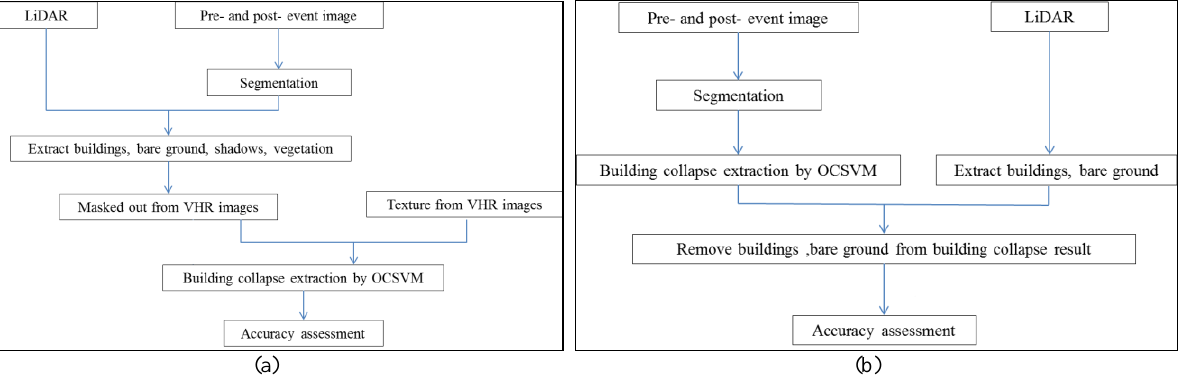
Figure 1. (a)Building collapse detection method proposed in this paper (b) Comparative